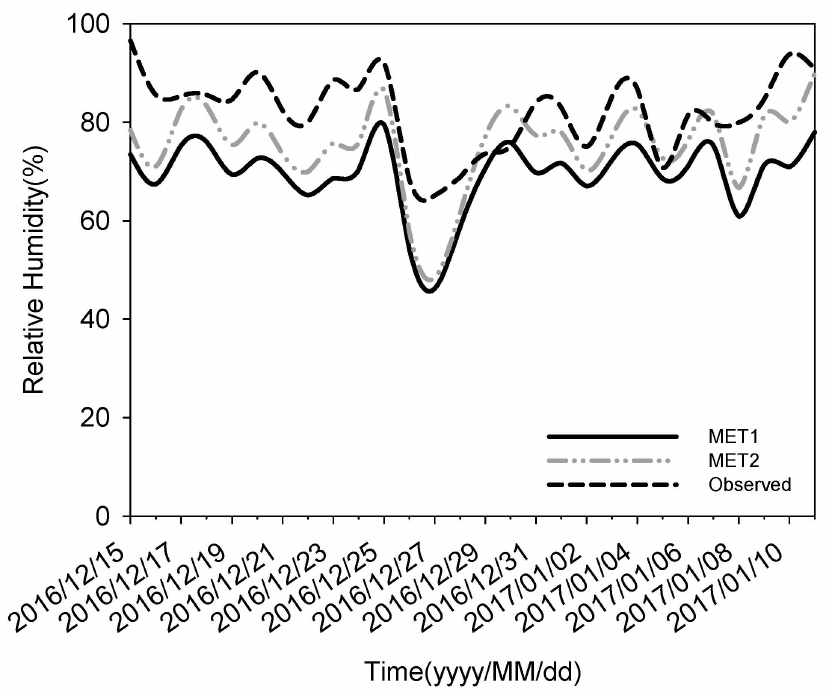
Figure 2. Time series of relative humidity (RH, unit: %) in simulation results of MET1 (black solid line), MET2 (grey dot dash line) and Observed (black dash line).